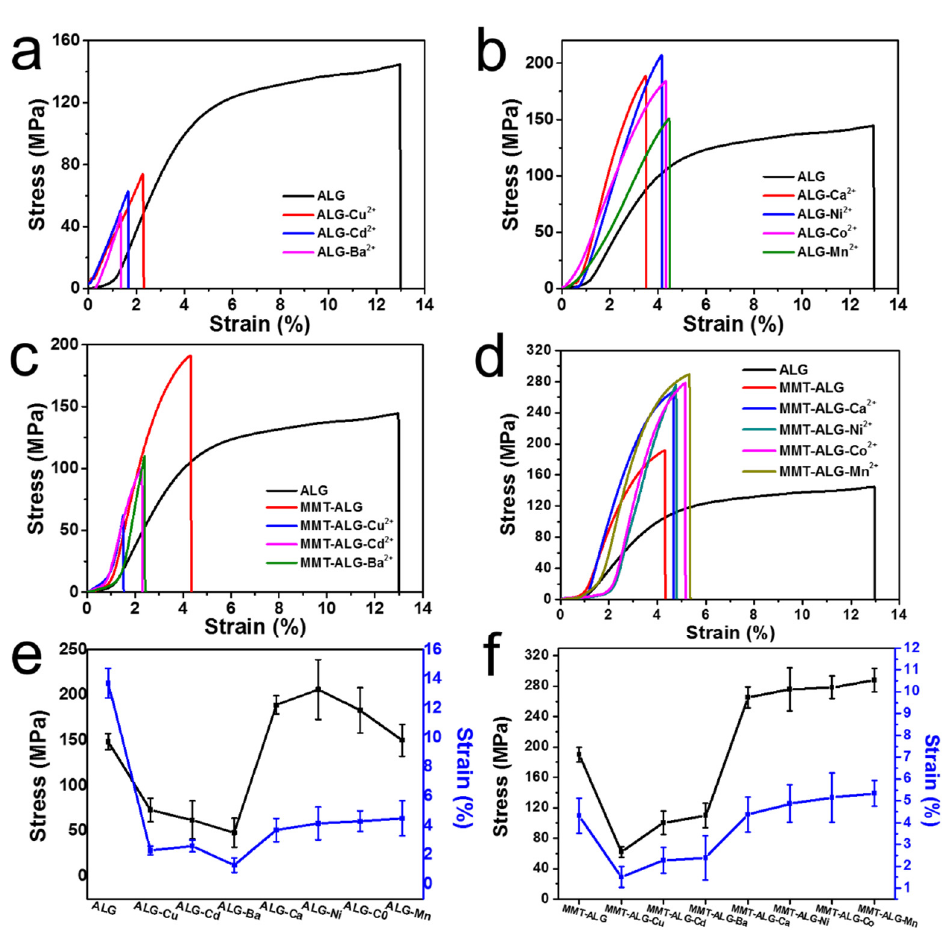
Figure 4. Tensile properties of the nacre-like films. ( a – d ) Stress–strain curves of nacre-like films; ( e , f ) Tensile strength/strain of nacre-like films.